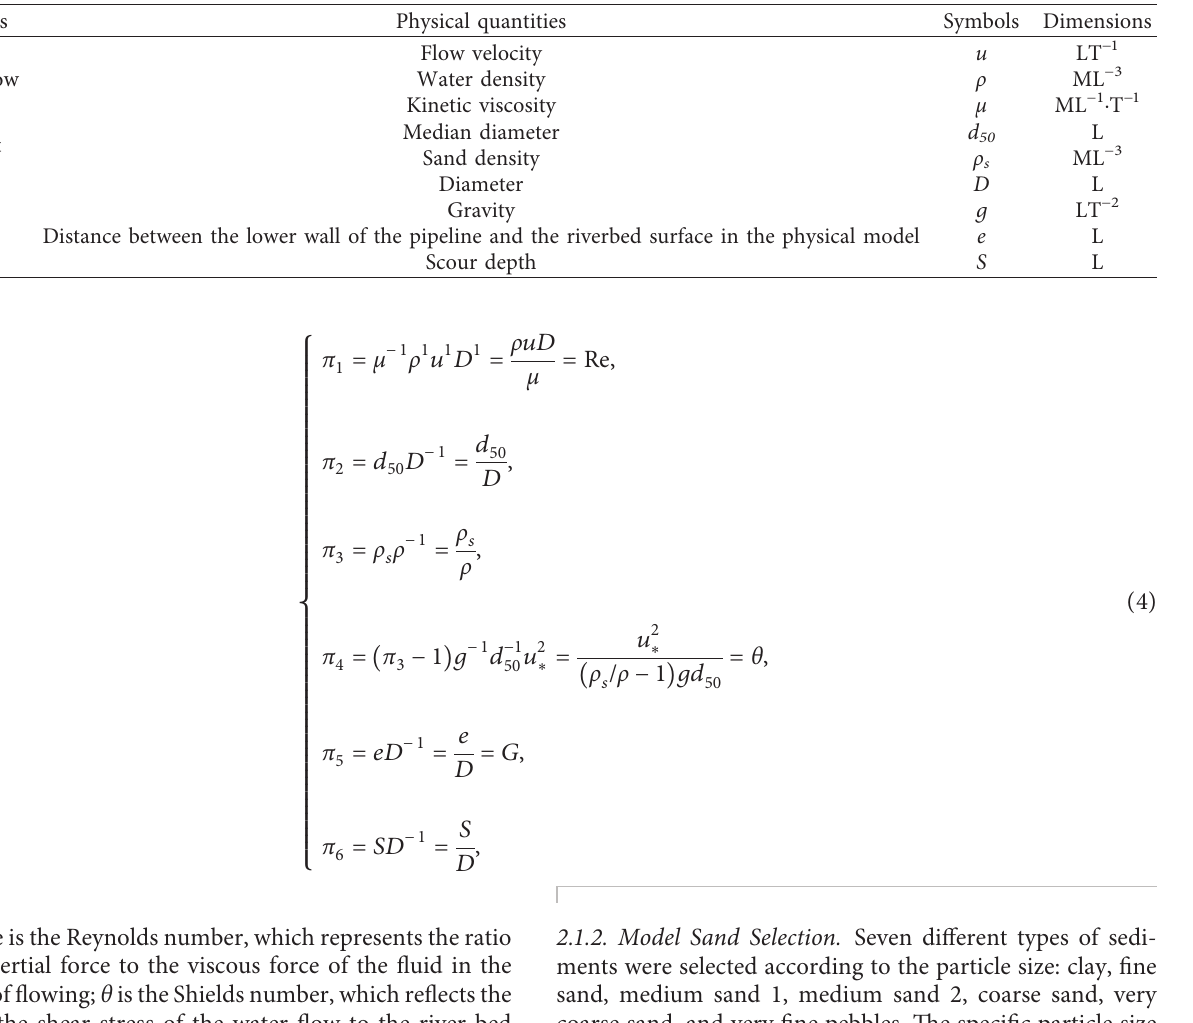
Table 1: Main physical